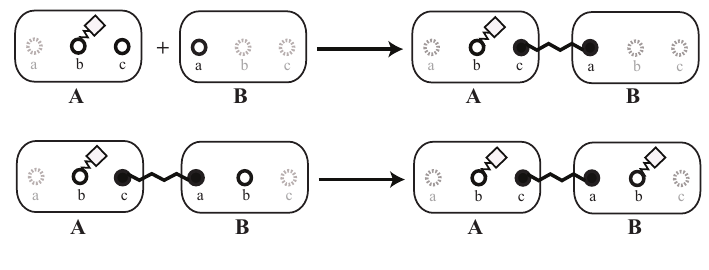
Figure 6. Context-dependent reaction rules that exclude the assembly in the absence of a nucleation structure. That is, polymerization will only happen when a protein modification at site b is already present. When a non-modified protein is bound to a modified one, the modification is passed on by the second rule. These new rules would have to replace the reaction rules defined in Figure 4 to avoid the context-free assembly reaction to happen, as